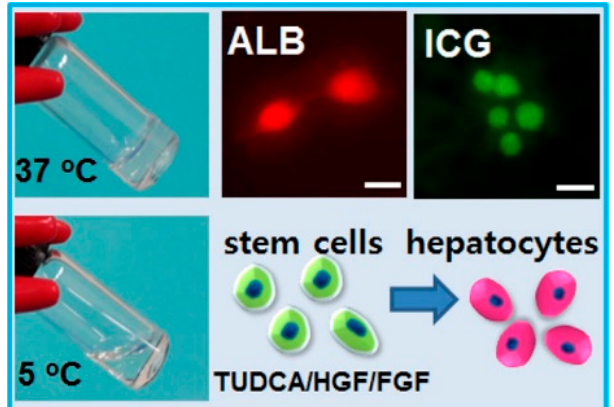
Figure 8. PEG-L-PA polypeptide thermogel system for hepatogenic differentiation of TMSCs. (reproduced with permission from [16]).